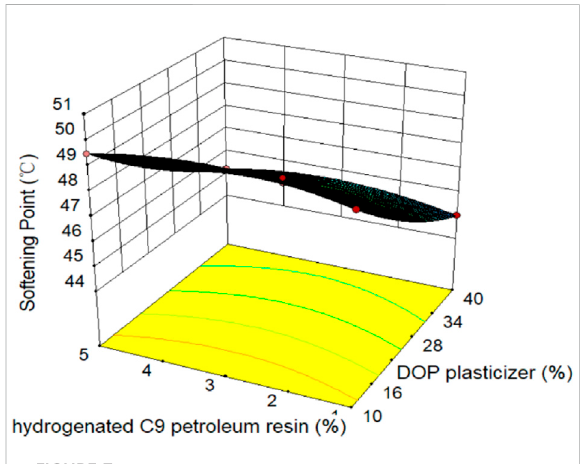
FIGURE 7 DOP plasticizer with hydrogenated C9 petroleum